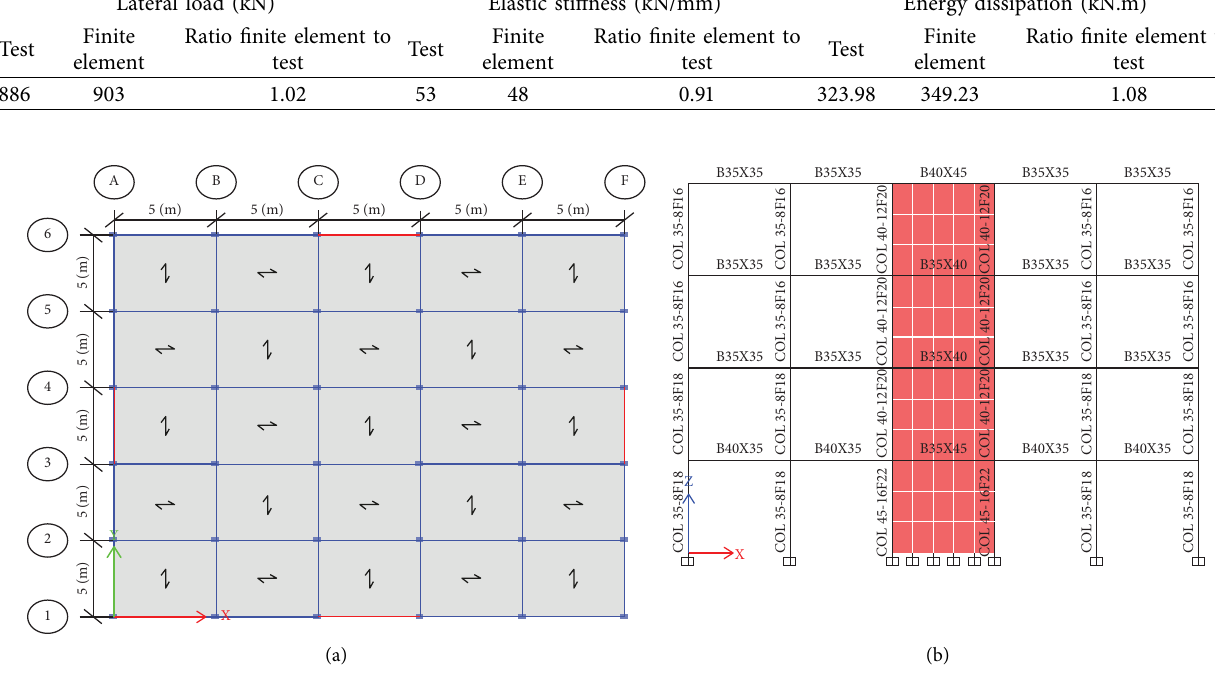
Figure 3: (a) Plan of structural models. (b) 4-story